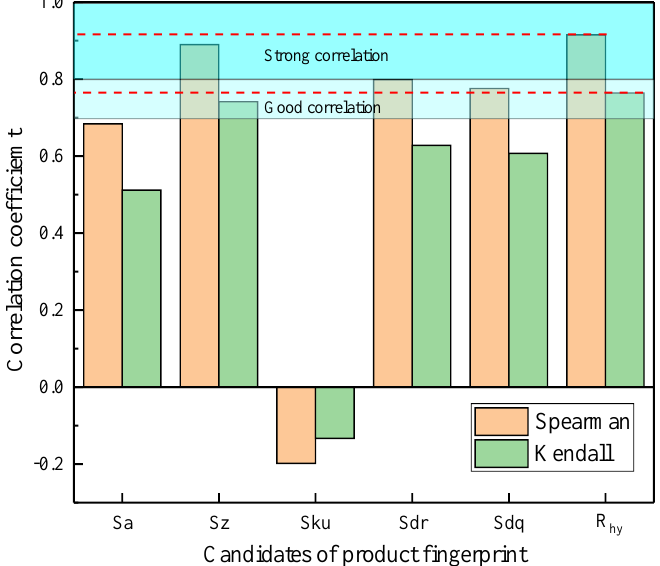
Figure 5. Spearman and Kendall rank correlation coefficient between the contact angle and six candidates of product fingerprint.